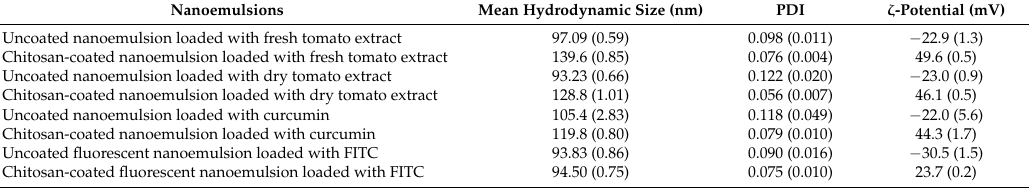
Table 2. Physical–chemical characteristics of nanocarriers used in this study: hydrodynamic size, polydispersity index and ζ potential.